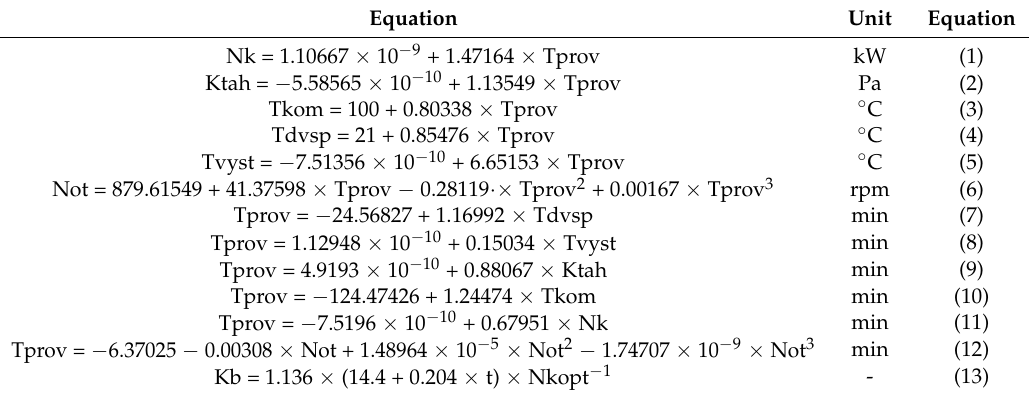
Figure 5. Dependence of change of the fan speed on the working time Tprov (min), for the boilers with power output up to 100 kW. Table 1. Working times of parameters for boilers 10–100 (kW) (Figure 6).